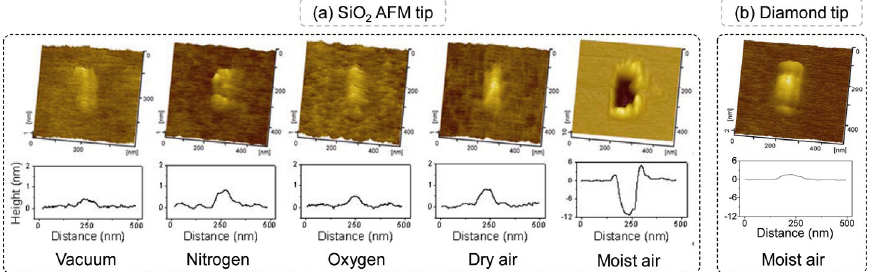
Fig. 13 Effect of environment and counter-face on nanowear of Si (100). (a) AFM images and profiles of nanowear scars on Si (100) surface against SiO 2 tip in various atmospheres (e.g., vacuum, nitrogen, oxygen, dry air, and humid air). (b) AFM image and profile of nanowear scar on Si (100) surface against diamond tip in humid air; RH was ~35%. For all tests, the applied load and total sliding cycle were 5 μ N and 200, respectively. Reproduced with permission from Ref. [142], © American Chemical Society